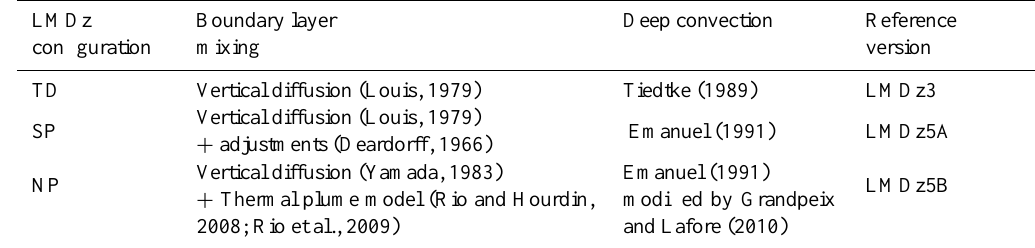
Table 1. Description of the sub-grid scale schemes used in the three configurations of LMDz (TD, SP and